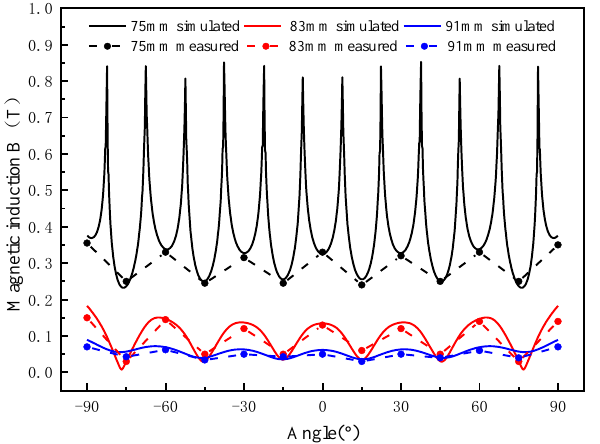
Figure 5. Comparison between simulated and measured values of magnetic induction intensity.